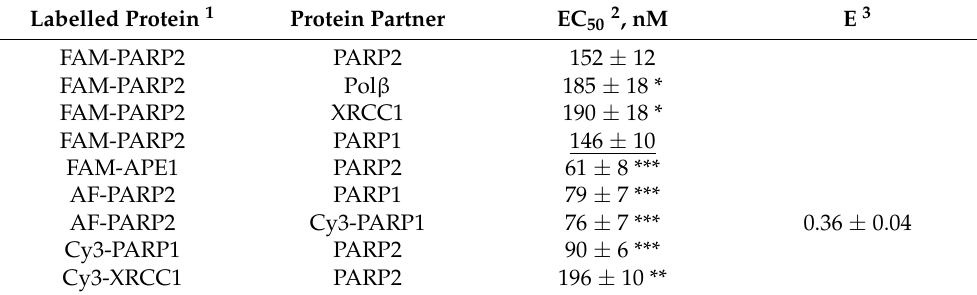
Figure 1. Detection of PARP2 complexes with various BER proteins by fluorescence titration of FAM-PARP2 or FAM-APE1. The FAM-labelled protein (40 nM) was excited at 482 nm in the absence or presence of increasing concentrations of the binding partner indicated, and the relative fluorescence intensities were monitored at 530 nm. Typical titration curves representing binding of FAM-PARP2 to Pol β , PARP2, PARP1, and XRCC1 ( A ), and complex formation between FAM-APE1 and PARP2 ( B ) show the best fits of the four-parameter equation (with R 2 values exceeding 0.98); no detectable change in the fluorescence intensity of FAM-PARP2 in the presence of APE1 is demonstrated ( B ). Table 1. Binding parameters of PARP2 interaction with BER proteins determined by fluorescent